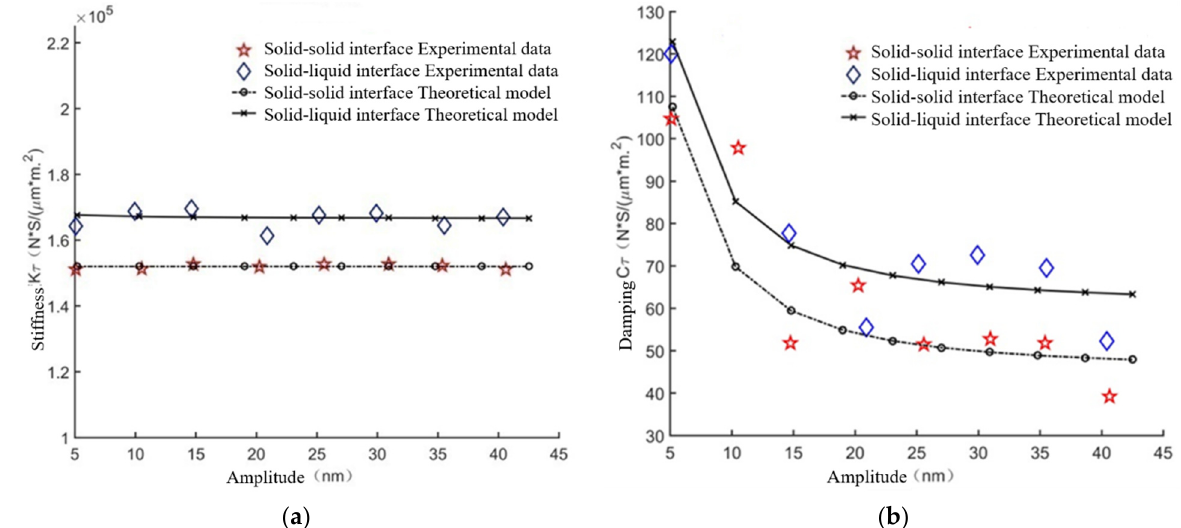
Figure 14. Comparative verification of the theoretical model and the experimental data of tangential contact stiffness and damping varying with displacement amplitude. ( a ) Tangential contact stiffness, ( b ) tangential contact damping.